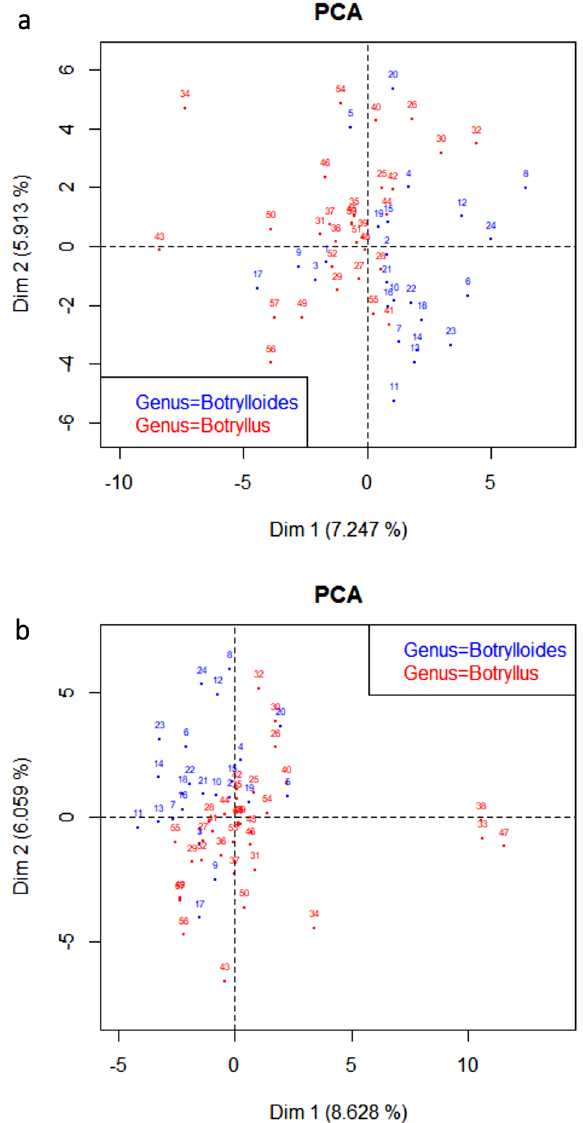
Figure 2. Graphical representation of Principal Components Analysis for morphological characters in botryllid species. The blue circles represent species in the genus Botrylloides, and the red circles species in the genus Botryllus. ( a ) Graph excluding three outlier species: Botryllus flavus (33), Botryllus magnus (38), and Botryllus renierii (47). ( b ) Graph including three outlier species: Botryllus flavus (33), Botryllus magnus (38), and Botryllus renierii (47). Species names corresponding to the numbers on the graphs in both ( a ) and ( b ) are as follows: (1) Botrylloides anceps (2) Botrylloides aureus (3) Botrylloides chevalense (4) Botrylloides